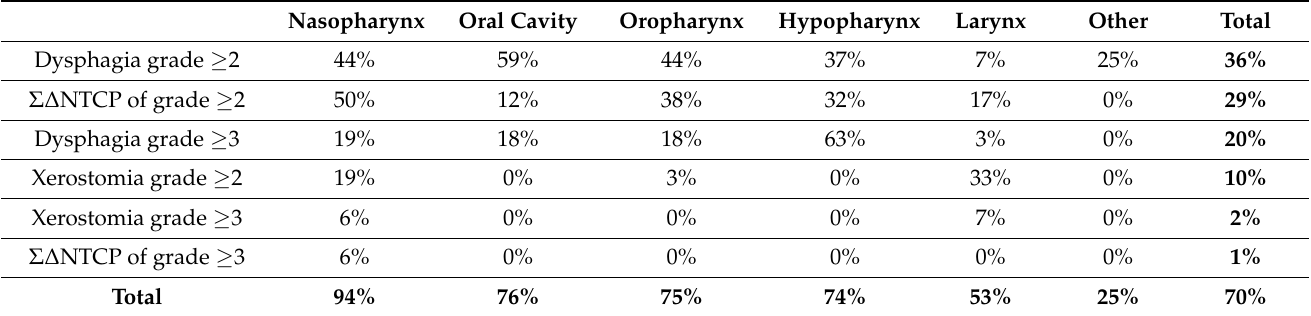
Table A3. PT selection frequency based on tumour location and NTCP models. Note that some patients qualified for protons based on more than one criteria.